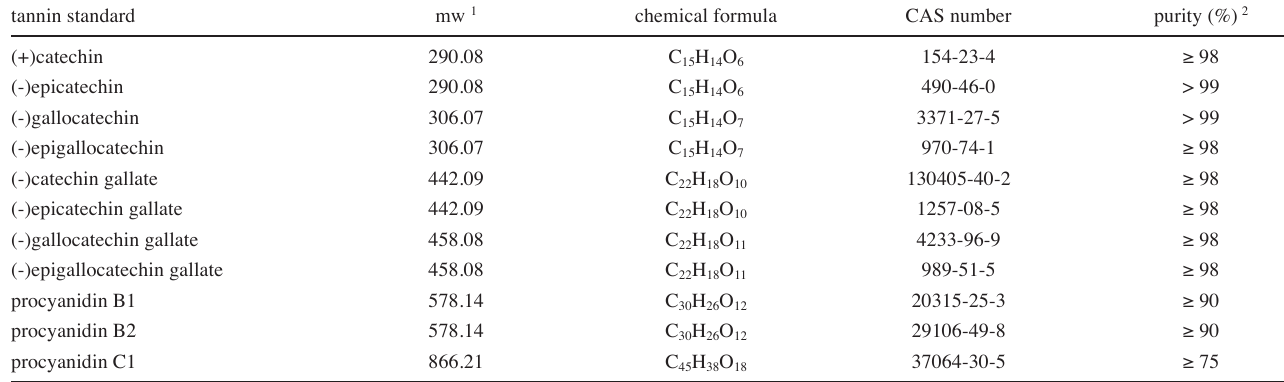
Tab. 1: Tannin standards with their respective molecular weight (mw), chemical formula, CAS number and purity. tannin